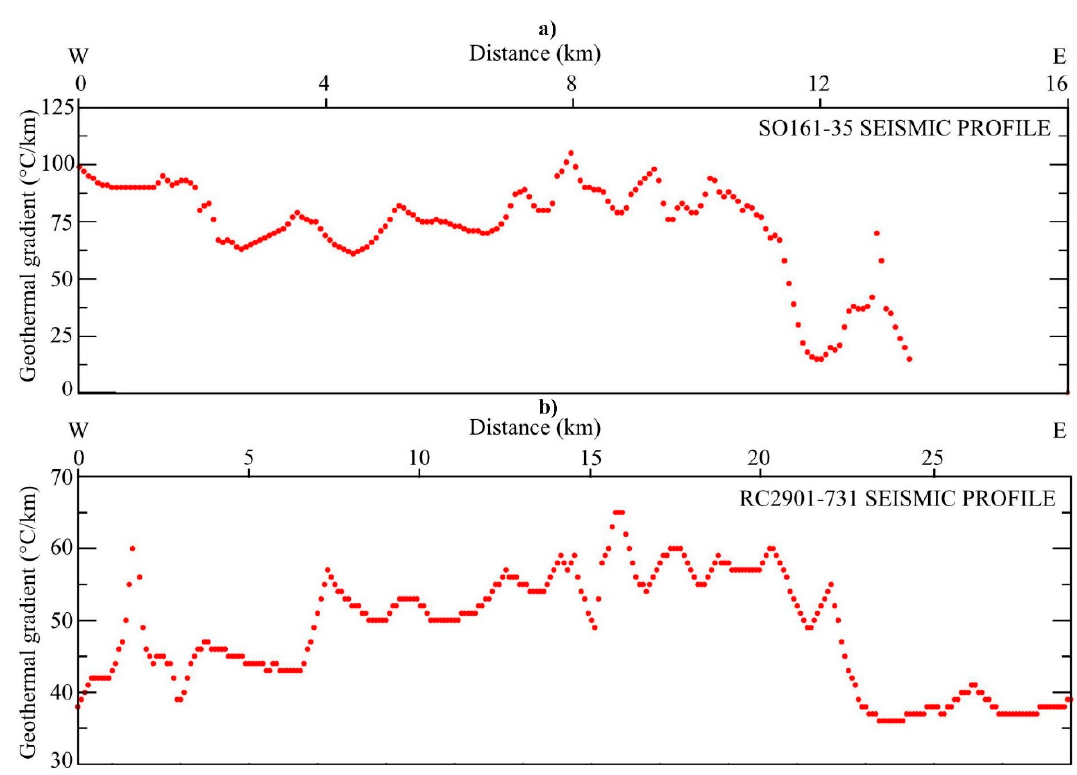
Figure 4. Estimated geothermal gradients. In ( a ) geothermal gradient for SO161–35 seismic profile; and ( b ) geothermal gradient for RC2901–731 seismic profile.